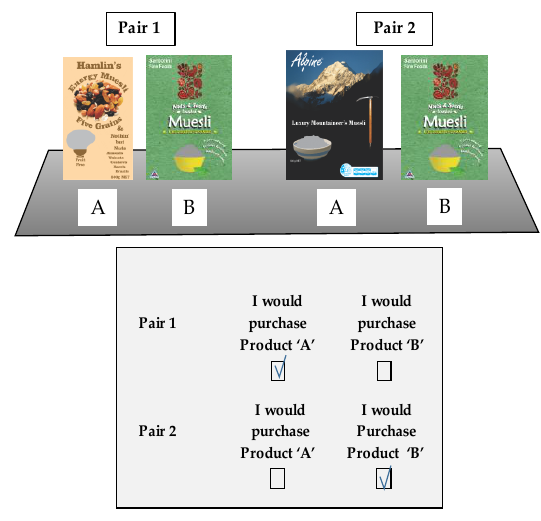
Figure 6. Experimental design—details of products and treatments.